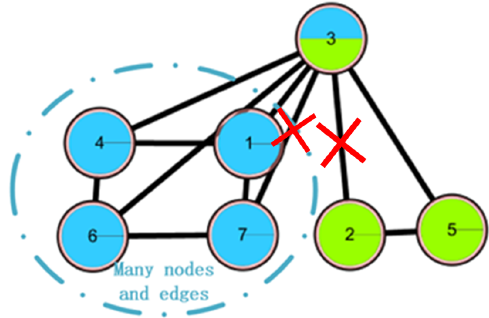
Figure 5. An example of the second pruning strategy.